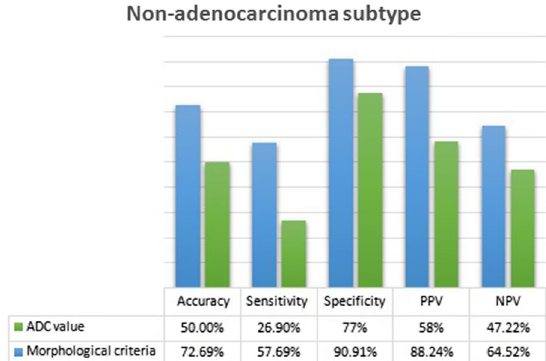
Fig. 6 Chart comparing ADC value versus morphological criteria for non-adenocarcinoma